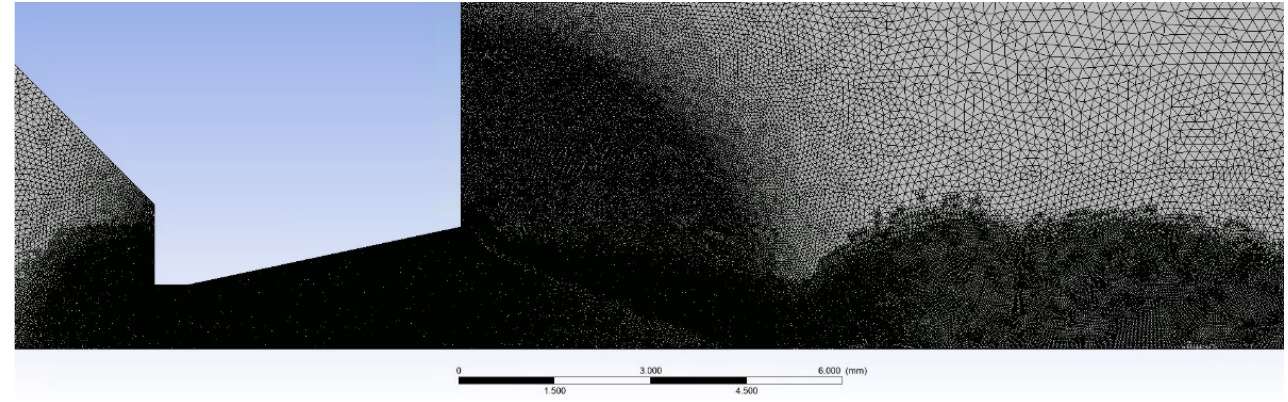
Figure 15. Detailed view of the area of the first shock wave behind the nozzle.